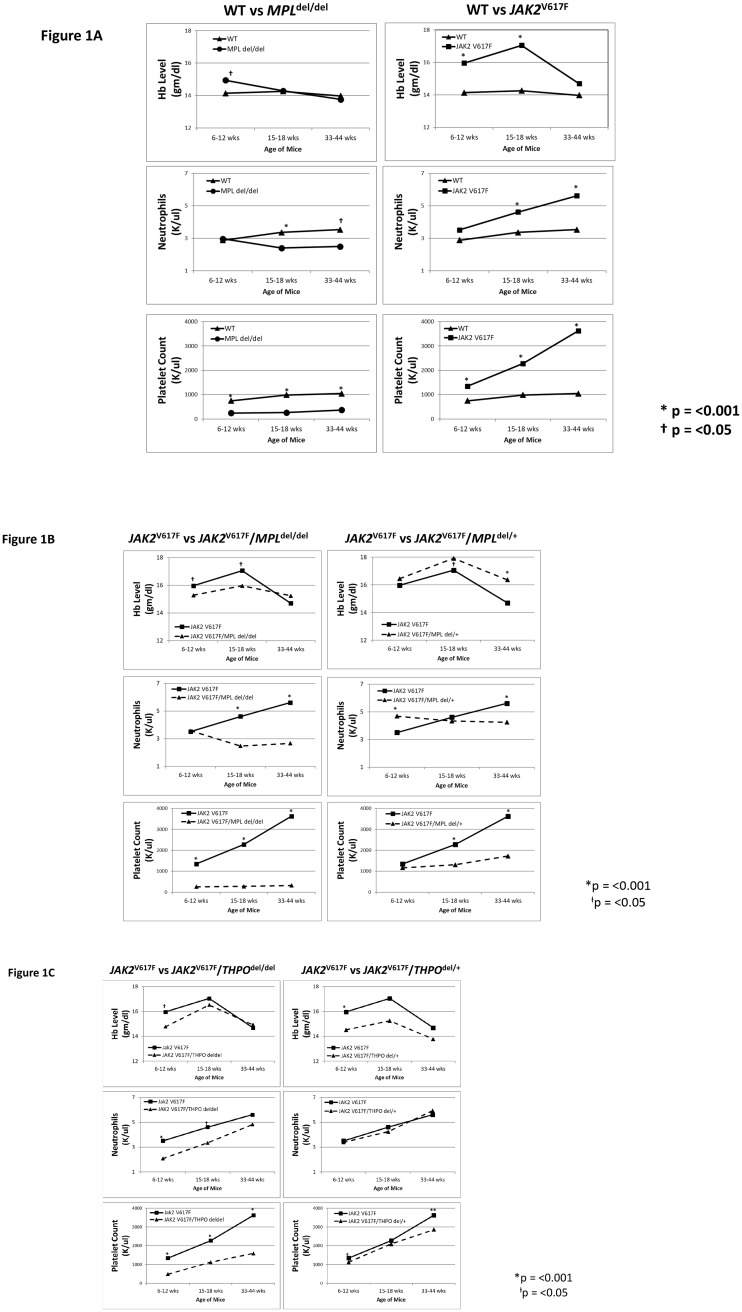
MPLdel and THPOdel genotypes mitigate increased hemoglobin, neutrophil and platelet levels in a JAK2V617F transgenic mouse model of PV.(A) Age-matched hemoglobin, neutrophil and platelet levels in wild-type (WT) mice compared to MPLdel/del and JAK2V617F transgenic mice over a period of 6 to 46 weeks. The symbols indicate statistically significant differences. The number of mice studied and complete statistical analysis for all genetic crosses is in the S3 Table in the Supporting information. (B) Age-matched hemoglobin, neutrophil and platelet levels in JAK2V617F transgenic mice compared to JAK2V617F/MPLdel/del and JAK2V617F/MPLdel/+ transgenic mice. (C) Age-matched hemoglobin, neutrophil and platelet levels in JAK2V617F transgenic mice compared to JAK2V617F/THPOdel/del and JAK2V617F/THPOdel/+ transgenic mice. *P < 0.001; ƗP <0.05.